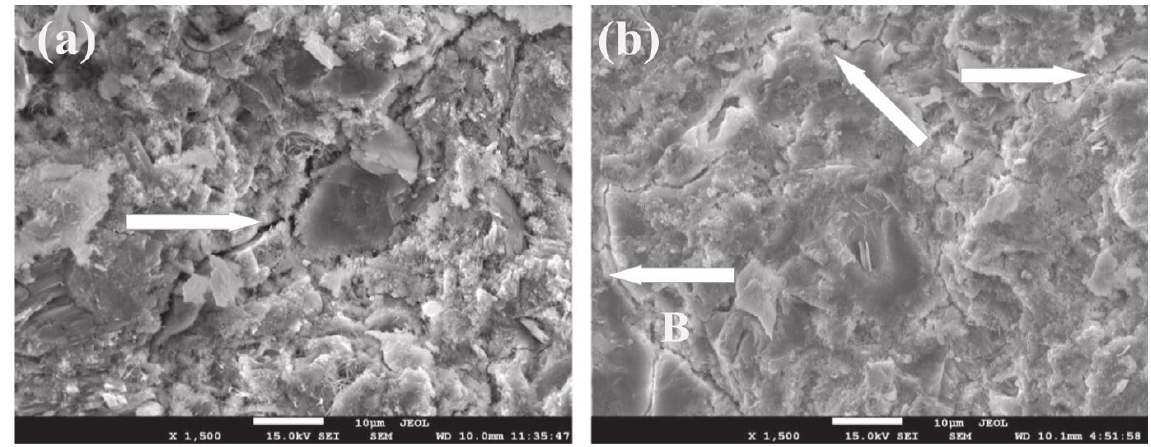
Figure 5: (a) SEM image of plain paste showing a straight-through type crack (arrow). (b) SEM image of GO–cement composite showing a number of fine cracks (arrows) with few branches